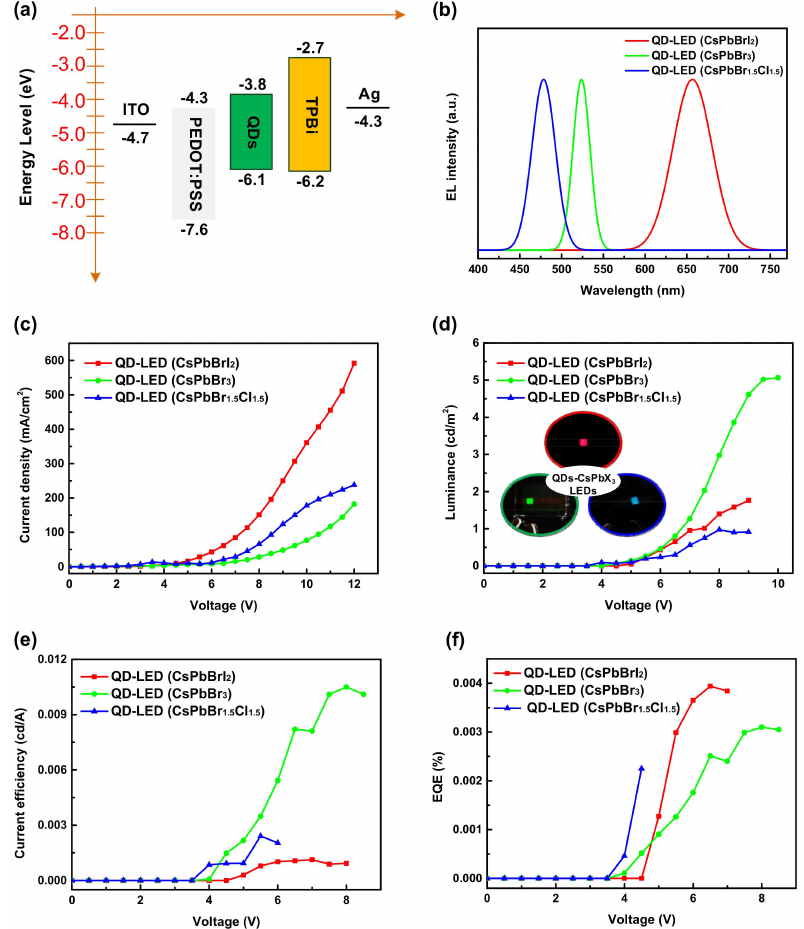
Figure 9. Perovskite QDs-CsPbBr 3 LED device performance: ( a ) Flat-band energy-level diagram of QDs-CsPbBr 3 LEDs; ( b ) Electroluminescence (EL) spectra of QDs-CsPbX 3 LED devices; ( c ) J–V characteristic; ( d ) L – V characteristic and the photographs showing various color emissions from the perovskite QDs-CsPbX 3 LEDs in operation (inset); ( e ) CE – V characteristic; ( f ) EQE - V